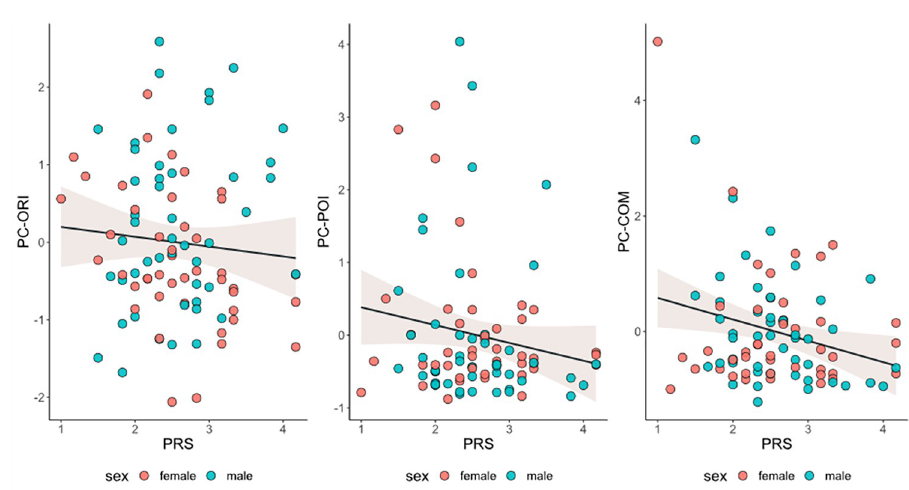
Fig 4. Linear association between maternal pandemic-related stress (PRS) during pregnancy and infants’ orienting (PC-ORI), pointing (PC-POI), communication (PC-COM) at 12-month-age. Note. All outcome variables on the y-axis are standardized (mean = 0, sd = 1). In regression model predicting PC-ORI, standardized estimate for PRS = -0.09, p = 0.41; In regression model predicting PC-POI, standardized estimate for PRS = -0.16, p = 0.16; In regression model predicting PC-COM, standardized estimate for PRS = -0.26, p = 0.02.